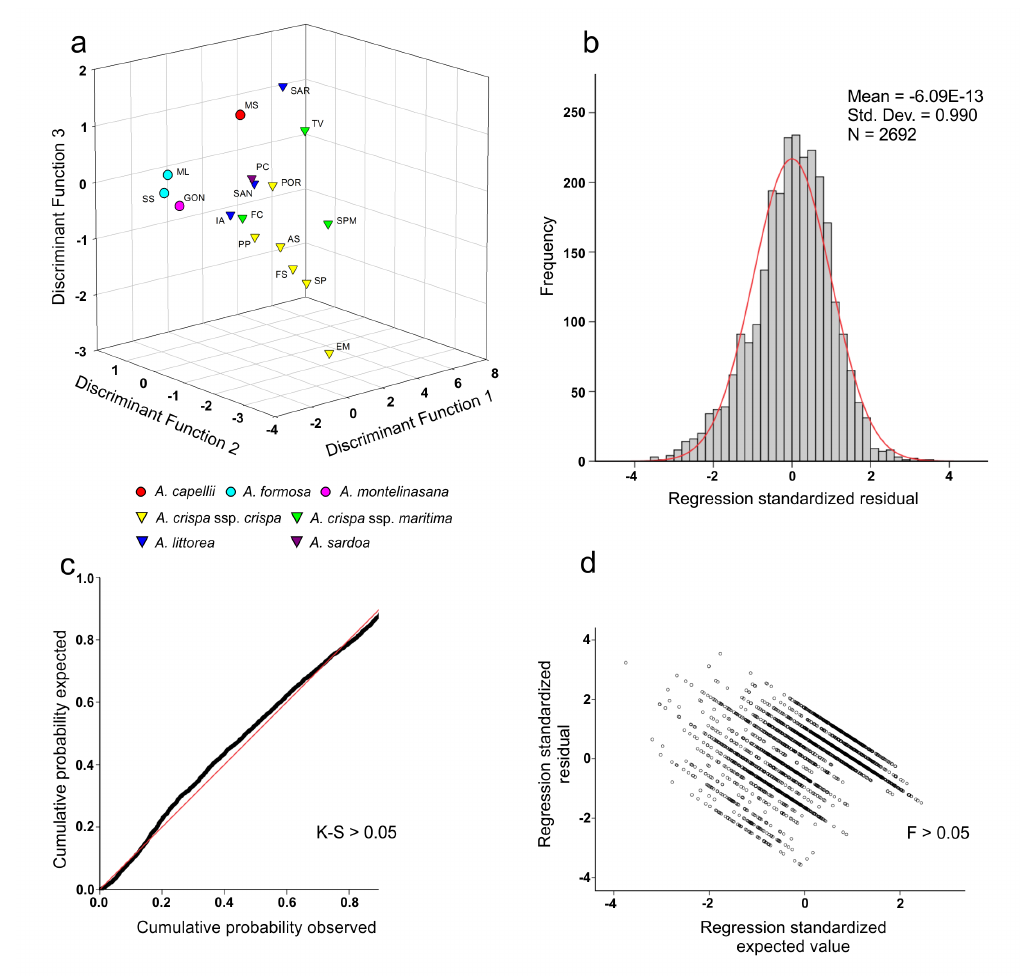
Figure 3. Distribution of the taxonomical groups’ centroids on the basis of three available discriminant functions. ( a ) Graphical representation of the discriminant scores of the 17 Anchusa populations; ( b ) Histogram of the standardized residuals; ( c ) Dispersion plot of the standardized residuals tested with Levene’s test (F); ( d ) Normal probability plot (P-P) tested with Kolmogorov–Smirnov’s test